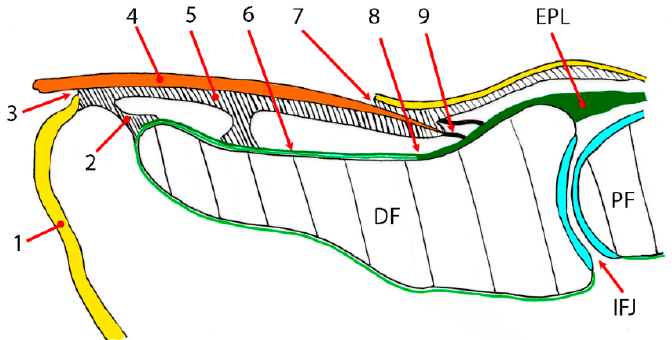
Figure 3. Drawing corresponding to Figure 4: (1) epidermis; (2) hyponychial phalangeal (anterior) ligament; (3) hyponychium; (4) nail plate; (5) nail matrix; (6) the superficial extensor pollicis longus (EPL) tendon bundle to the distal phalanx of the thumb aponeurotic expansion; (7) cuticle (8) superficial EPL tendon bundle that continues to the distal phalanx of the thumb; (9) superficial fibers of the EPL bundles. DF—distal phalanx; EPL—extensor pollicis longus; IFJ—interphalangeal joint; PF—proximal phalanx. Table 1. Measurements of the length of the dorsal aspect of the distal phalanx of the thumb, until its end, where the extensor pollicis longus (EPL) tendon is disinserted. SD—standard deviation. Specimen Number Total ( N = 5)